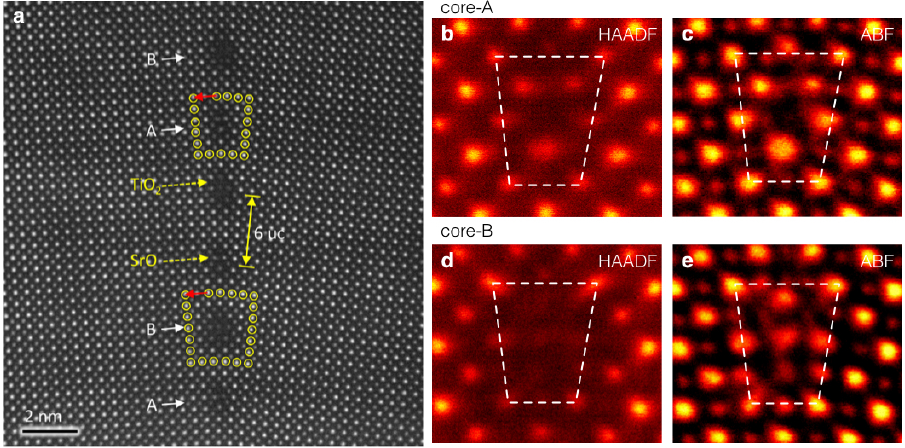
Figure 22. ( a ) Atomic-resolution HAADF STEM image obtained from SrTiO 3 bicrystal with a [001]/(100) 10° tilt grain boundary; ( b – e ) enlarged HAADF and ABF STEM images of core-A and